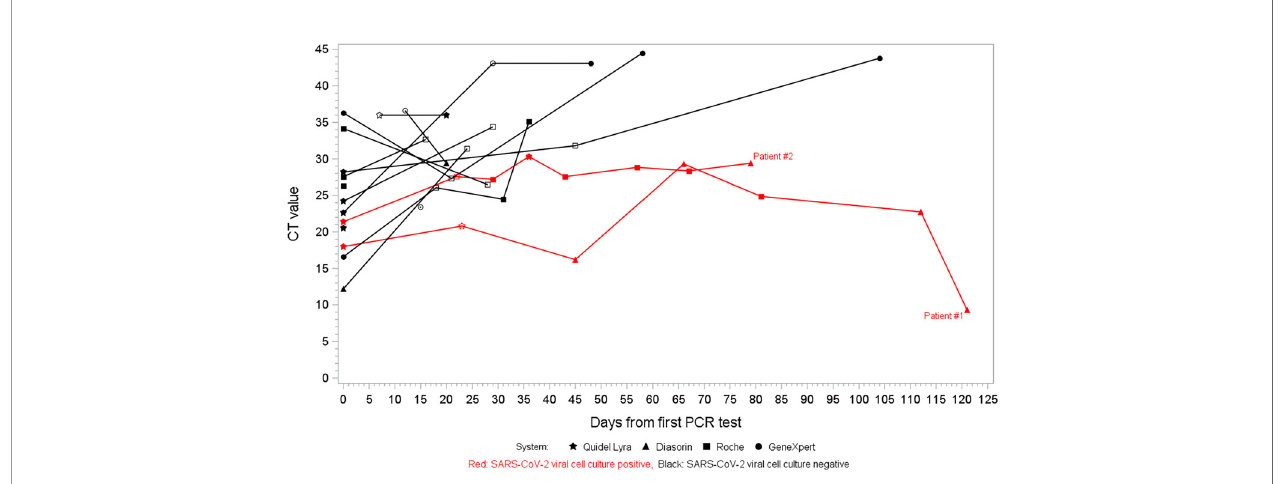
FIGURE 1 | Open symbol indicates sample was